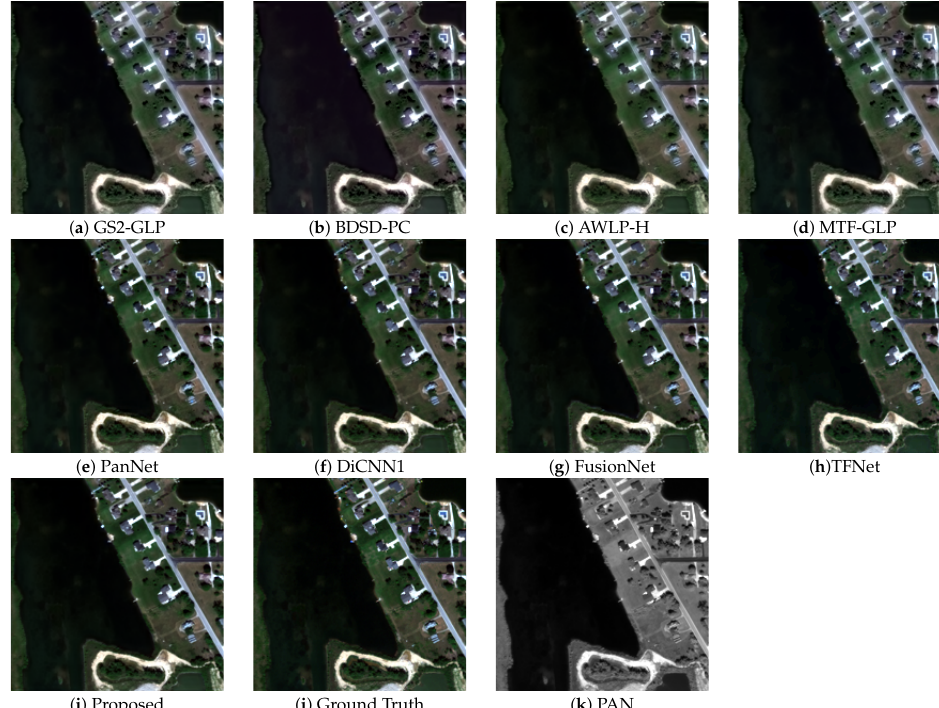
Figure 4. Fusion results of a group of reduced-resolution samples on the GeoEye-1 dataset.